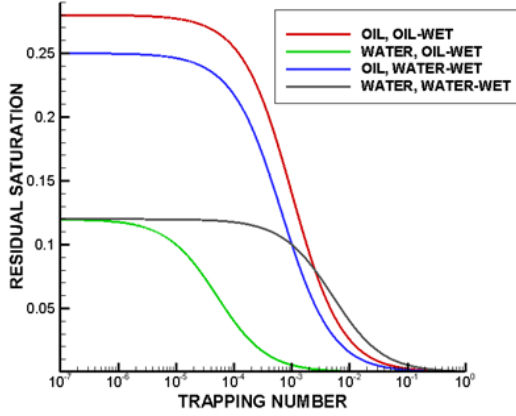
Figure 1: Capillary desaturation curves used in simulations